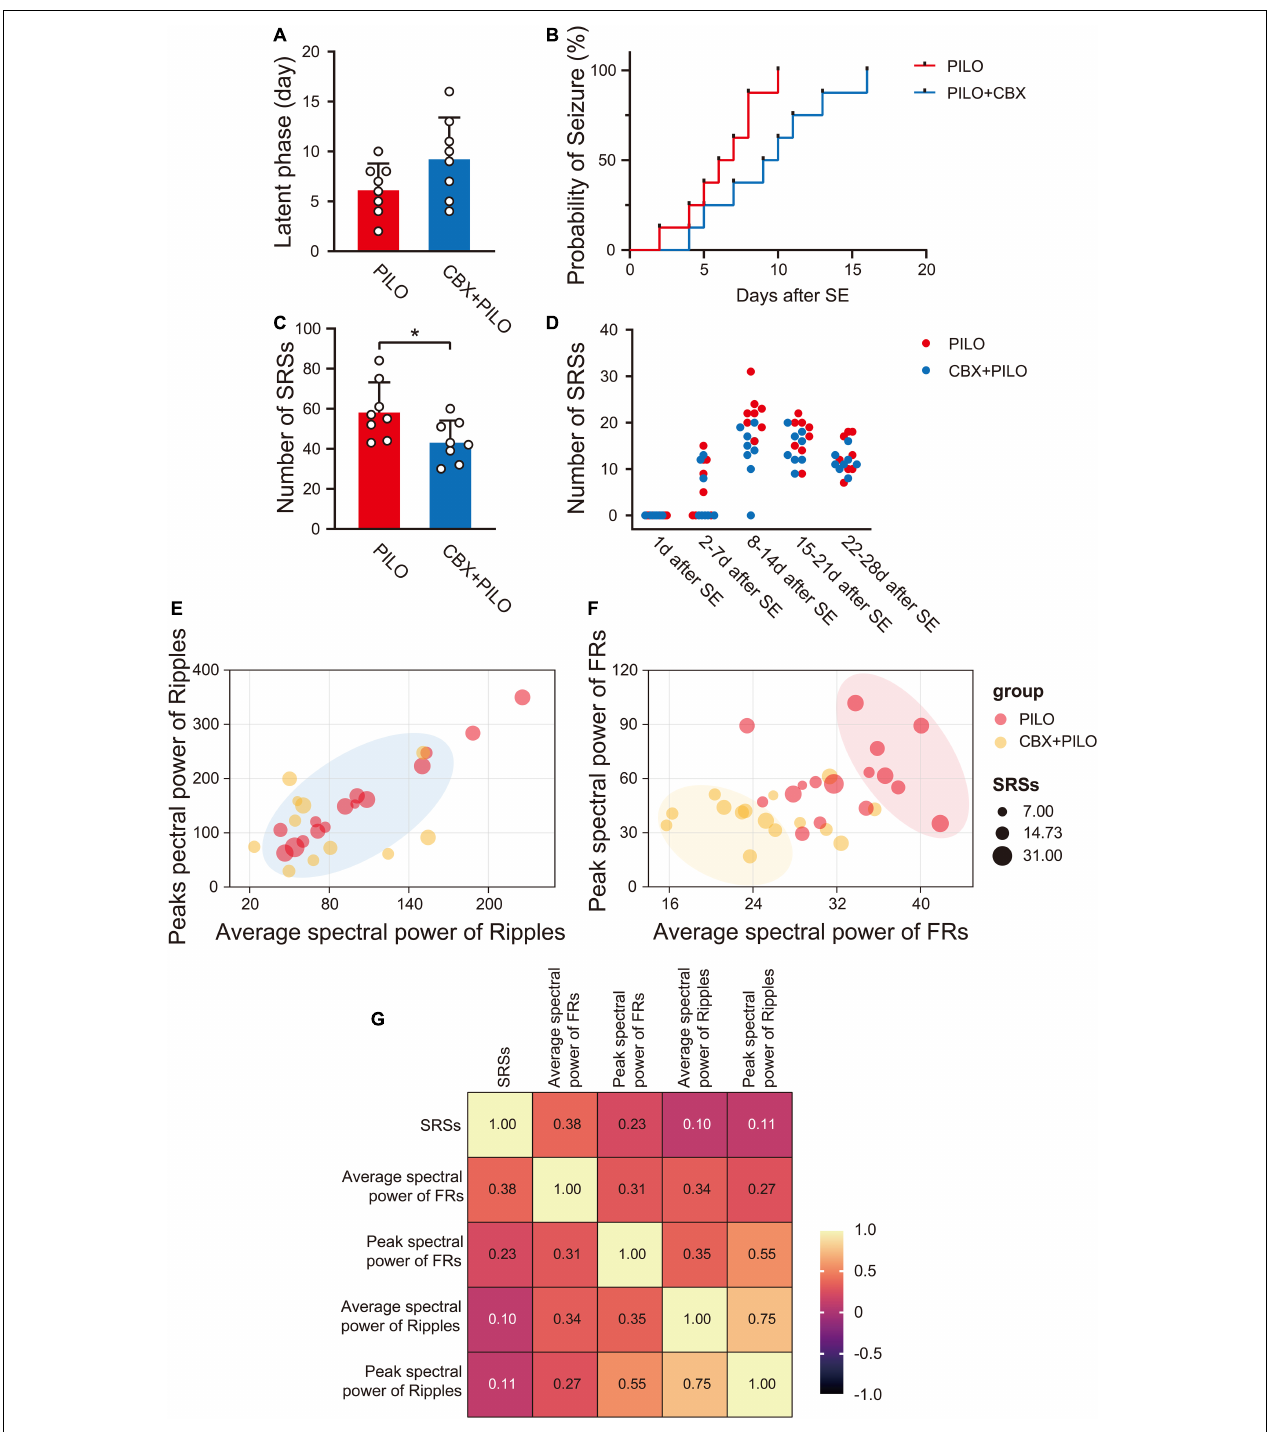
FIGURE 2 | Lithium-pilocarpine produced chronic SRSs in rats. (A) Average latent phase in PILO and CBX + PILO groups. (B) Incidence curve of epileptic rats over time, showing latent phase to first seizure after SE. (C) Average number of SRSs in PILO and CBX + PILO groups during the 4 weeks after SE. (D) The number of SRSs per week after SE in PILO and CBX + PILO groups. (E,F) Bubble diagram of the relationship between the number of SRSs and the spectral power of ripples/FRs at 2 and 4 weeks after SE in PILO and CBX + PILO groups, the gathered bubbles of the two groups means weak correlation, and the separated bubbles of the two groups means strong correlation. (G) The correlation coefficient matrix of the number of SRSs and the spectral power of HFOs at 2 and 4 weeks after SE (average spectral power of FRs, r = 0.38; peak spectral power of FRs, r = 0.23; peak spectral power of ripples, r = 0.11; average spectral power of ripples, r = 0.10). * P < 0.05; SRSs, spontaneous recurrent seizures; PILO, pilocarpine; SE, status epilepticus; FRs, fast ripples; HFOs, high-frequency oscillations.